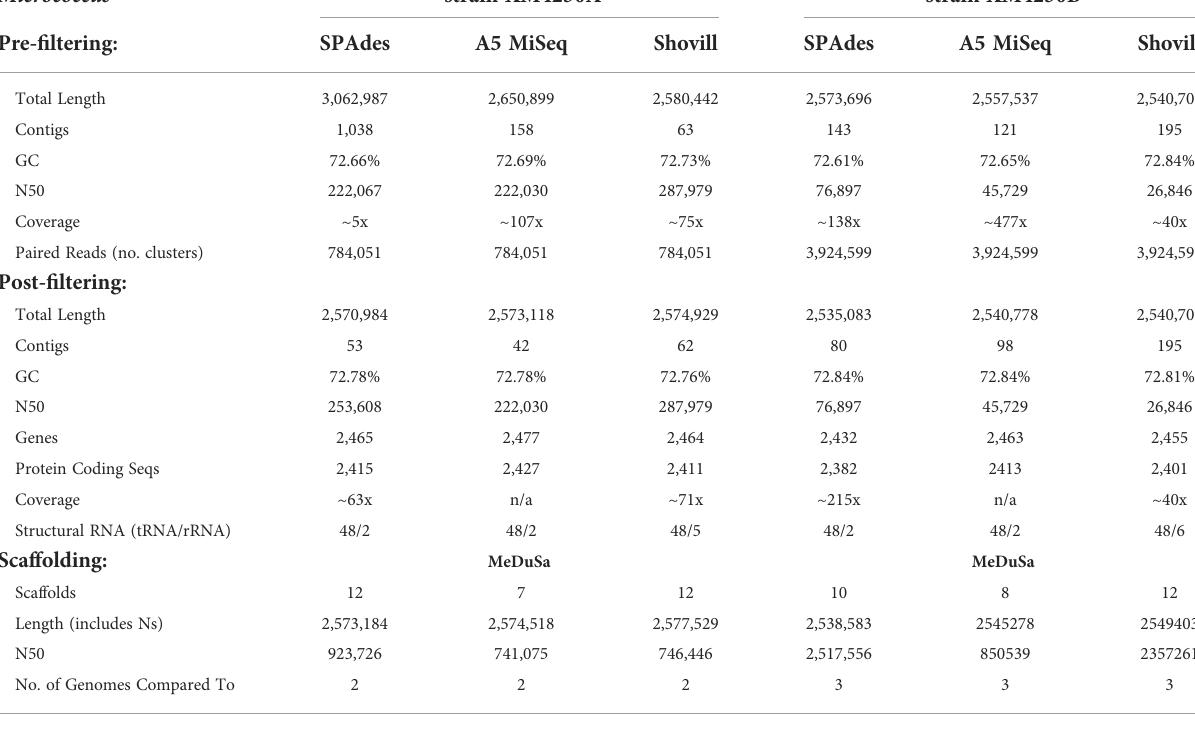
TABLE 2 Comparative assembly statistics for Micrococcus strains.